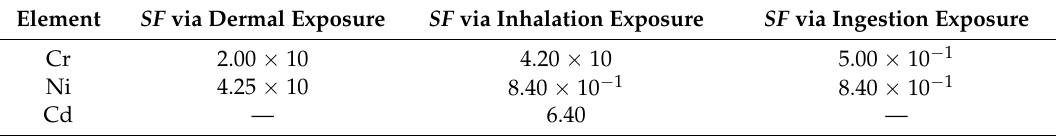
Table 5. Carcinogenic factors of heavy metals through three exposure pathways (mg · (kg · d) − 1 ). Element SF via Dermal Exposure SF via Inhalation Exposure Cr —